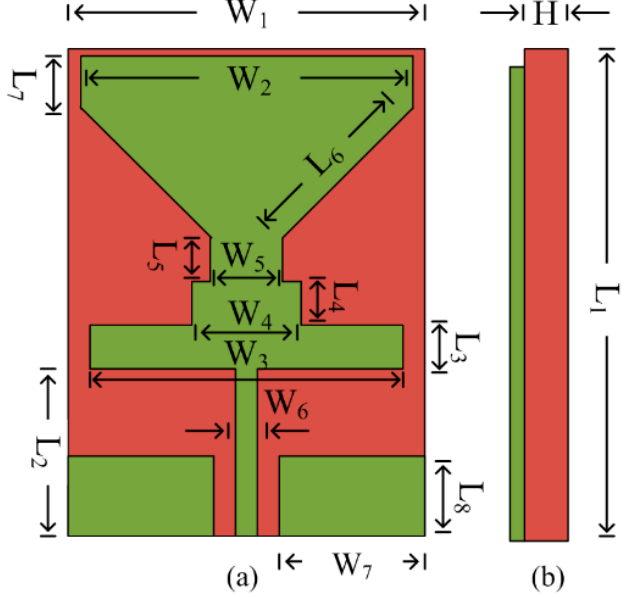
Figure 1. Geometrical configuration of proposed compact CPW-fed antenna Operating on ISM and WLAN applications ( a ) top-view ( b ) side-view.